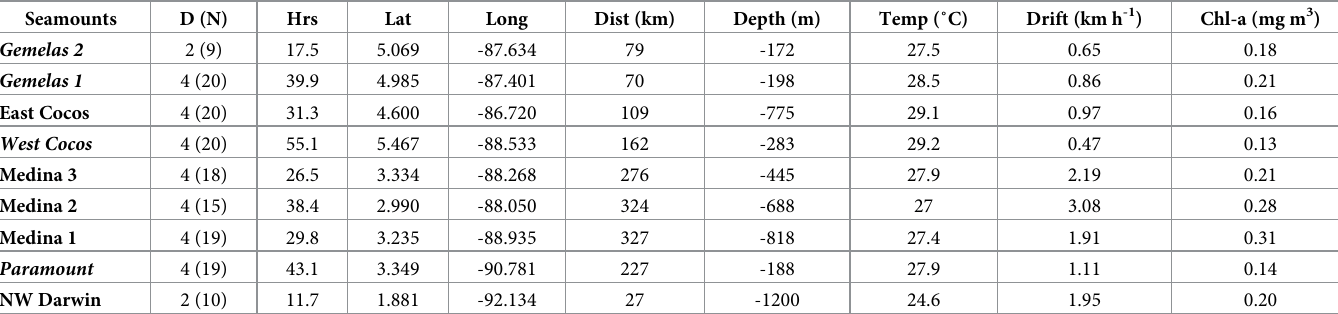
Table 1. Survey effort, location, depth and environmental data associated with seamounts surveyed along the Cocos Ridge.